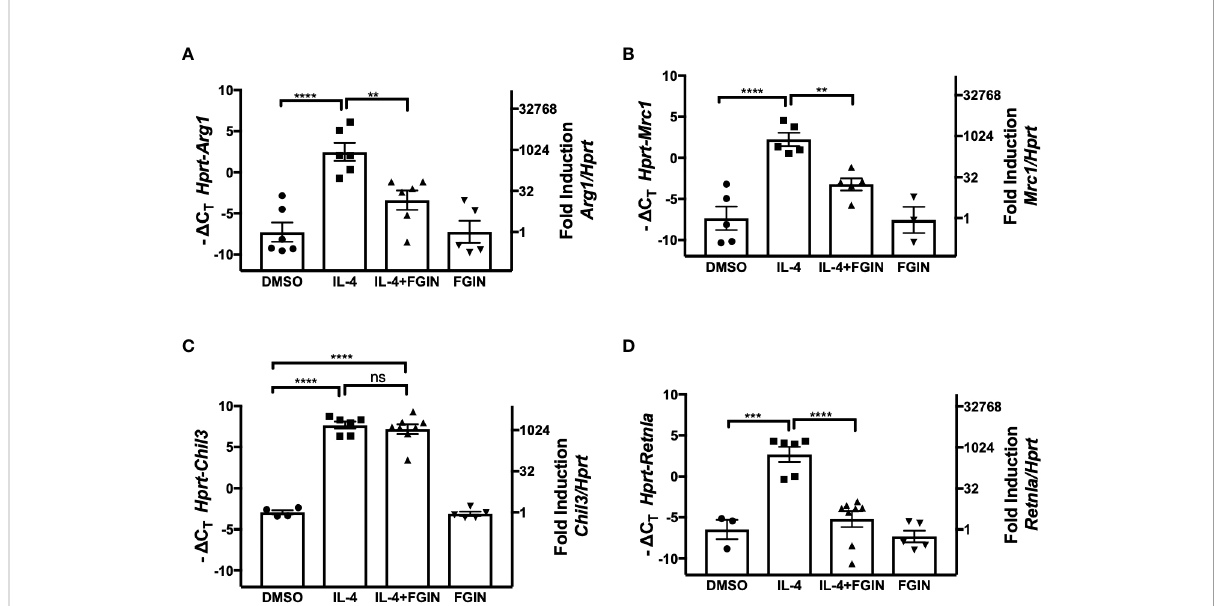
FIGURE 7 Effect of TSPO agonist on IL-4-induced M2 macrophage gene expression. Thioglycollate-elicited peritoneal macrophages were harvested from 6-8 week old C57BL/6J mice and stimulated with IL-4 at 5 ng/ml in the absence or presence of 10 µM of FGIN-1-27 (TSPO agonist) for 48 hr, and RNA was processed. Gene expression of Arg1 (A) , Mrc1 (B) , Chil3 (C) , and Retnla (D) were quanti fi ed by qRT-PCR. Data from 3 independent experiments is presented as - D C T (left y-axis) and fold induction (2 - DD CT value; right y-axis), mean ± SEM. Statistical analysis (one-way ANOVA with Sidak ’ s multiple comparison post-hoc test) was performed on the - D C T values. ****p <0.0001 and **p<0.01 ns, not signi fi